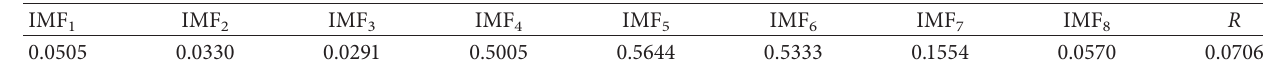
Figure 3: Decomposed IMFs of the simulation signal Y ( t ) using the ESMD method. Table 1: Spearman’s rho values of IMFs and R